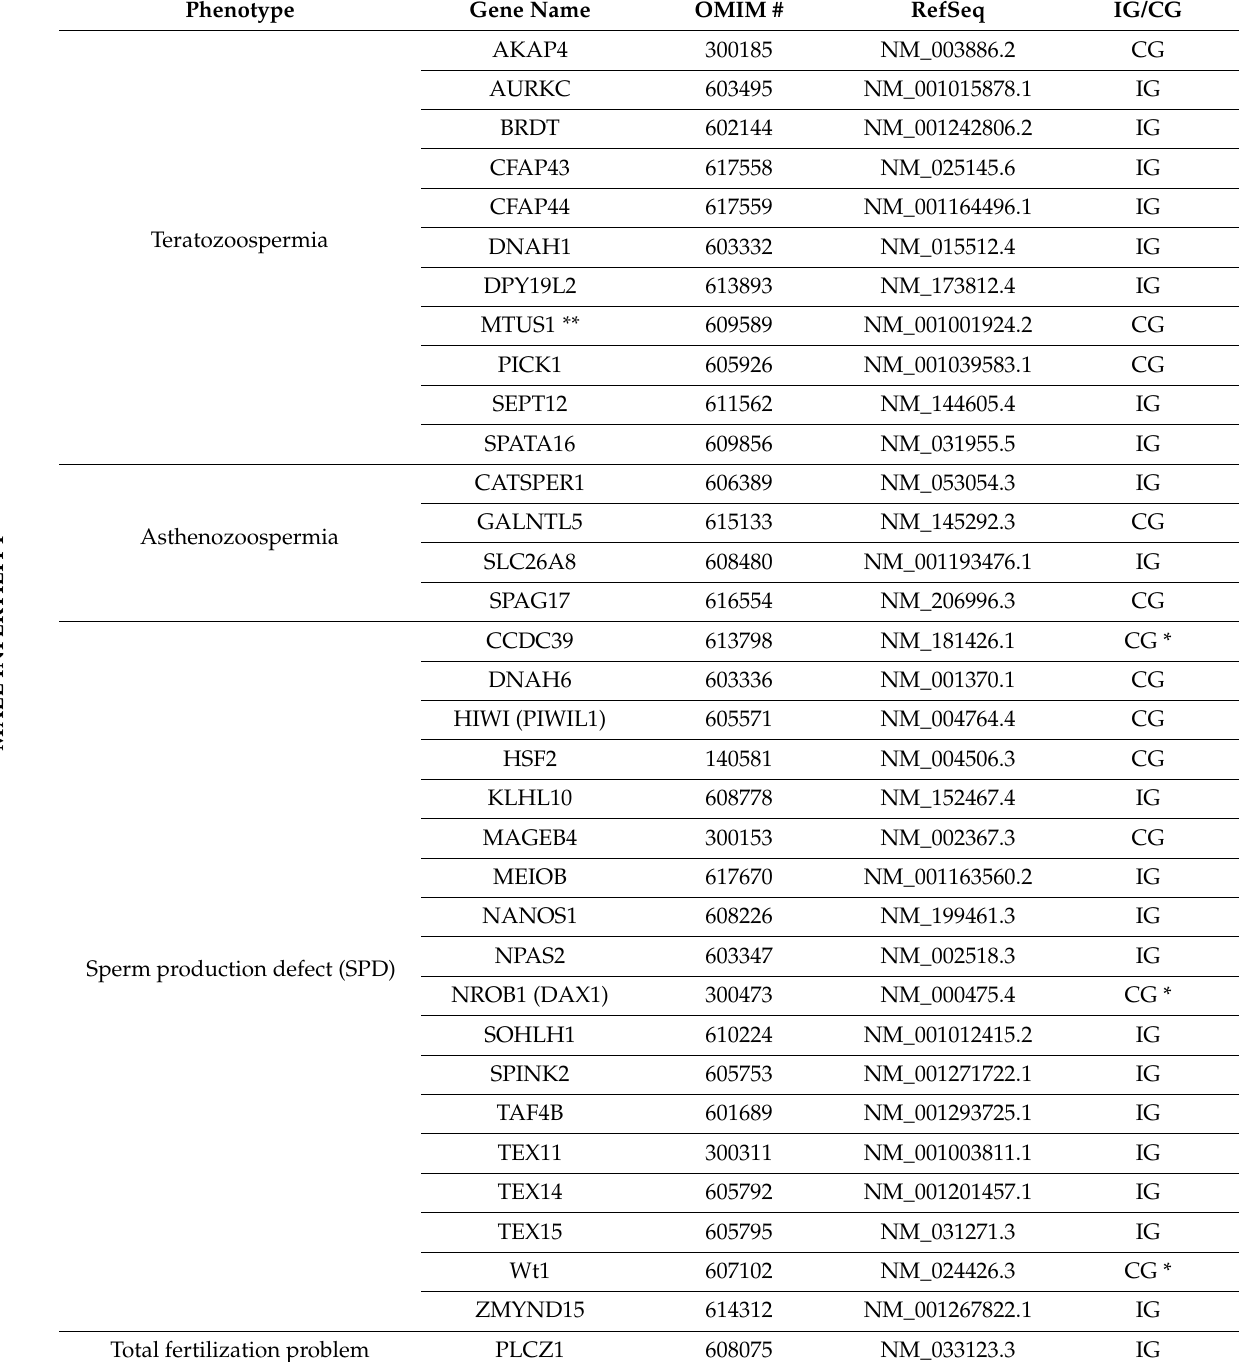
Table 3. Selected genes for infertility panel: 34 genes related to non-syndromic male infertility, 15 genes related to female infertility, [13 genes for premature ovarian insufficiency (POI), and 2 genes for oocyte maturation defect (OOMD)]; 2 shared genes for non-syndromic male and female infertility have been included in the